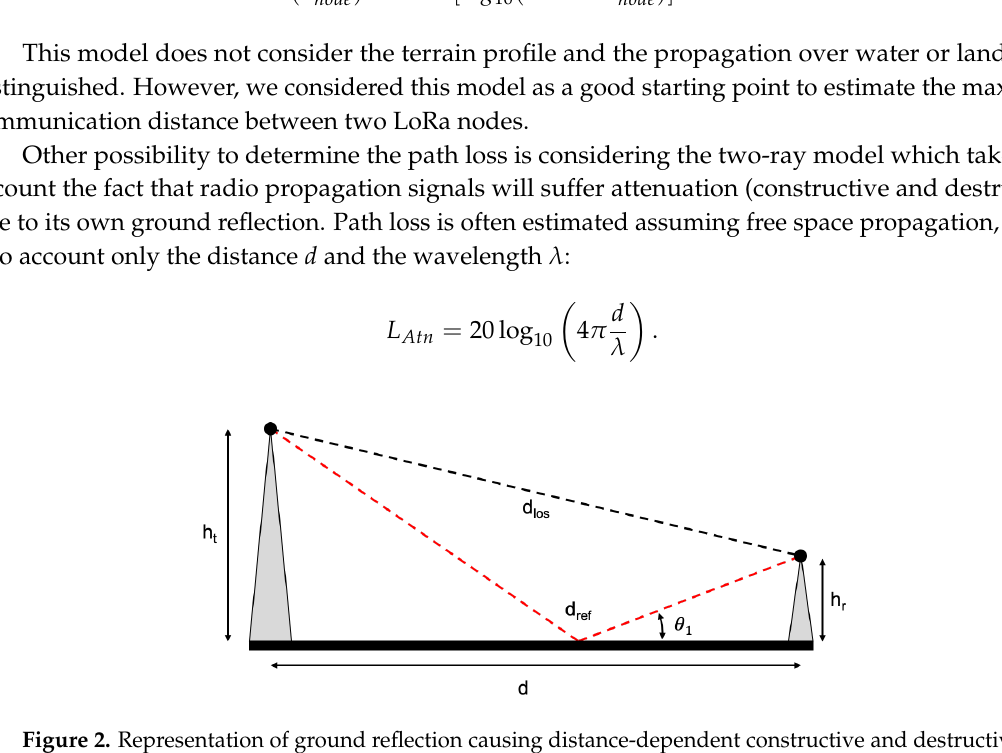
Figure 2. Representation of ground reflection causing distance-dependent constructive and destructive signal interference considered by the two-ray